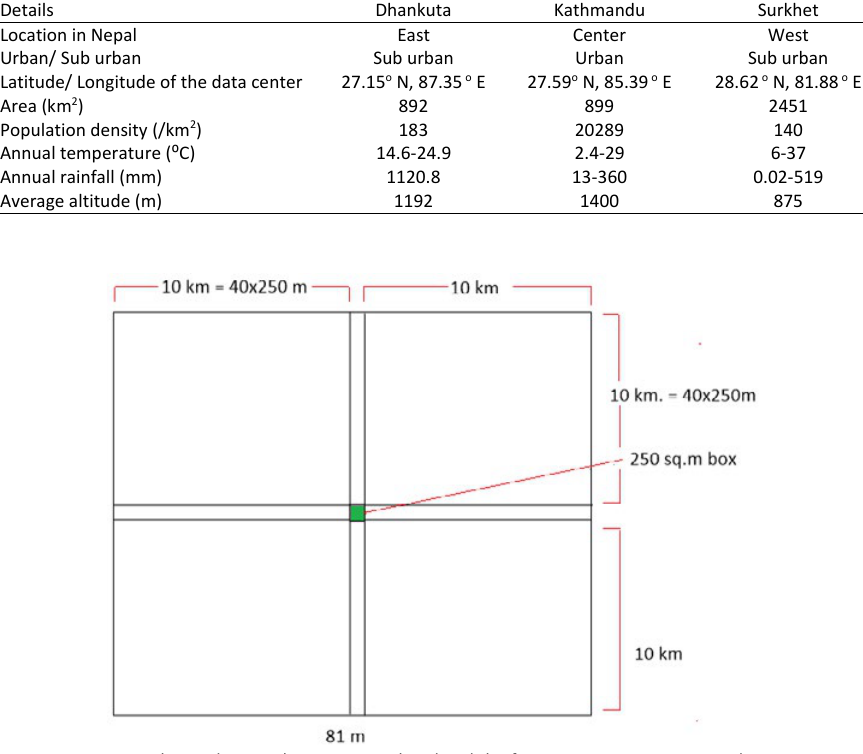
Fig. 3: The study area showing central grid and the four way extention in NDVI data Fig. 3. The study area showing central grid and the four way extention in NDVI